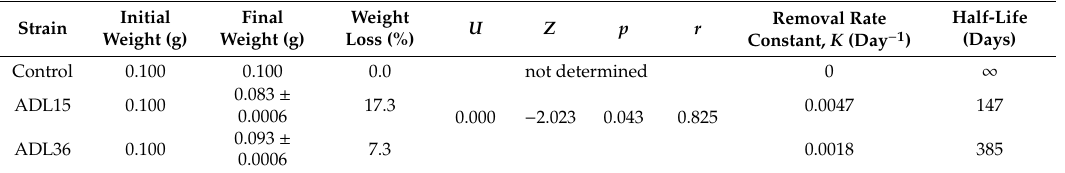
Table 1. Summary statistics (Mann-Whitney U test) of polypropylene (PP) microplastic weight loss in cultures of the Antarctic bacteria Pseudomonas sp. ADL15 and Rhodococcus sp.